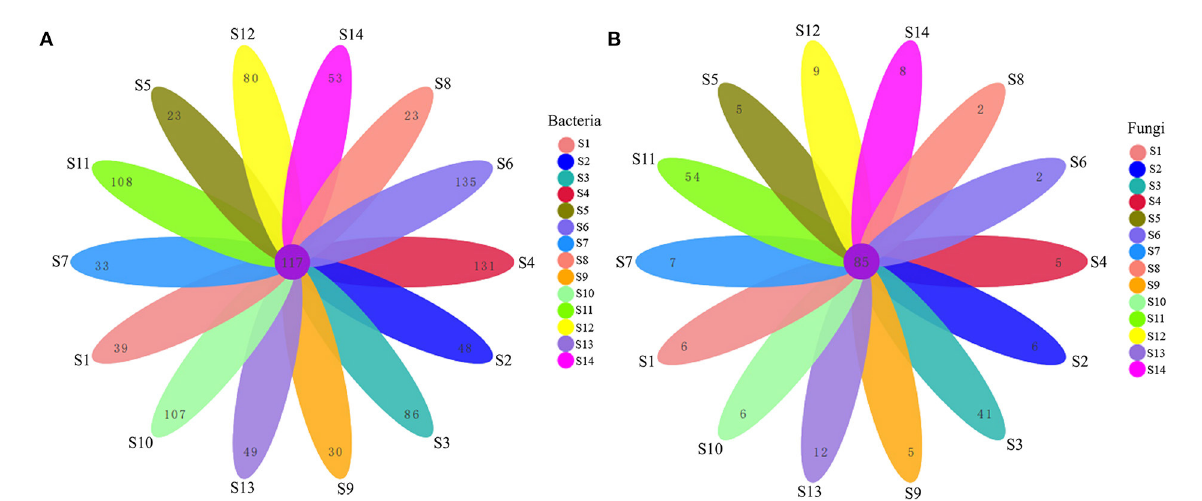
FIGURE1 Venn petals of bacteria (A) and fungi (B) at the OTUS level showing the number of commonly and uniquely expressed genes collected the Festuca sinensis seeds from different geographical locations.